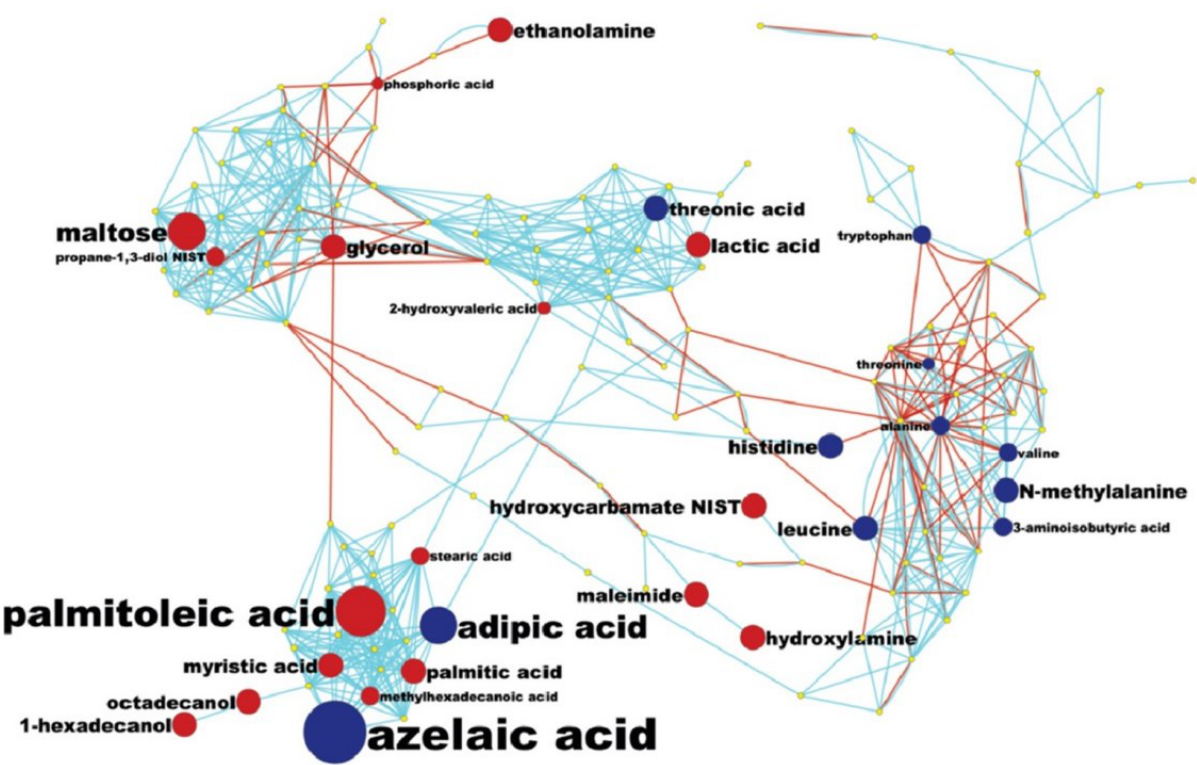
Figure 4. MetaMapp mapping of metabolomic analysis of lung cancer blood samples: a MetaMapp clustering metabolites based on biochemical reactant pairs in the KEGG